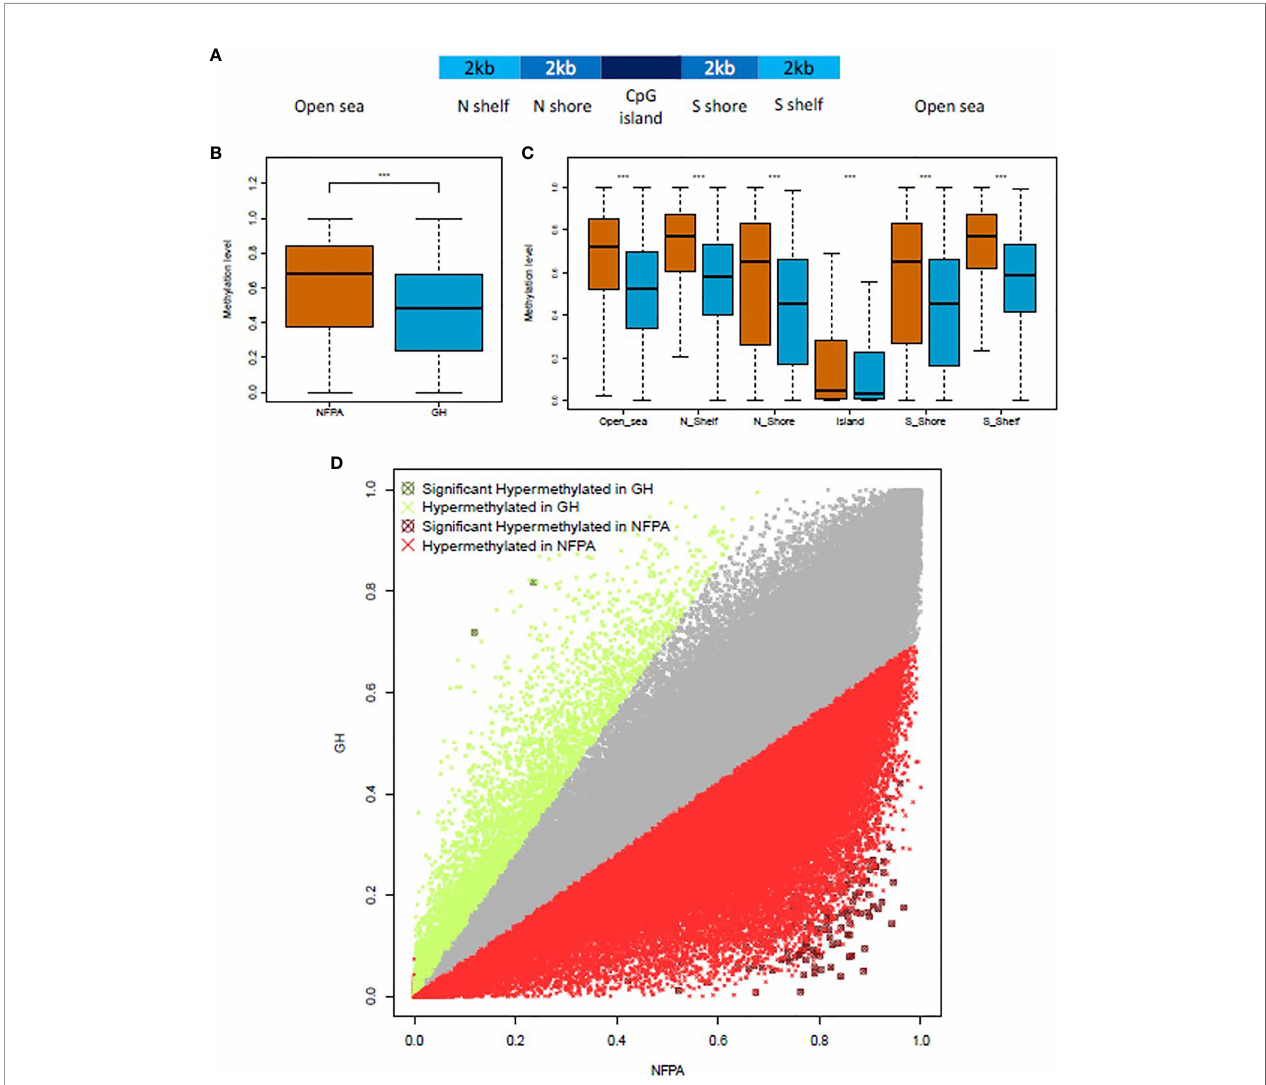
FIGURE 1 | NFPAs are hypermethylated when compared to GH-secreting tumors. (A) Schematic representation of the CpG-related region annotation. (B) Boxplot showing the global level of methylation in nonfunctioning pituitary adenomas (NFPAs — brown) and GH-secreting (blue) tumors. (C) Methylation levels in CpG-related regions. (D) The scatterplot compares the methylation levels of 184,841 regions in NFPAs (x-axis) and GH-omas (y-axis). Data points in gray did not pass the Log 2 fold change cutoffs. Points in red or green passed the Log 2 fold change cutoffs. Points in dark red or dark green were signi fi cantly hypermethylated in NFPAs or GH, respectively. Mann – Whitney test was used in (B, C) t-test was used in (D) . P < 0.0001